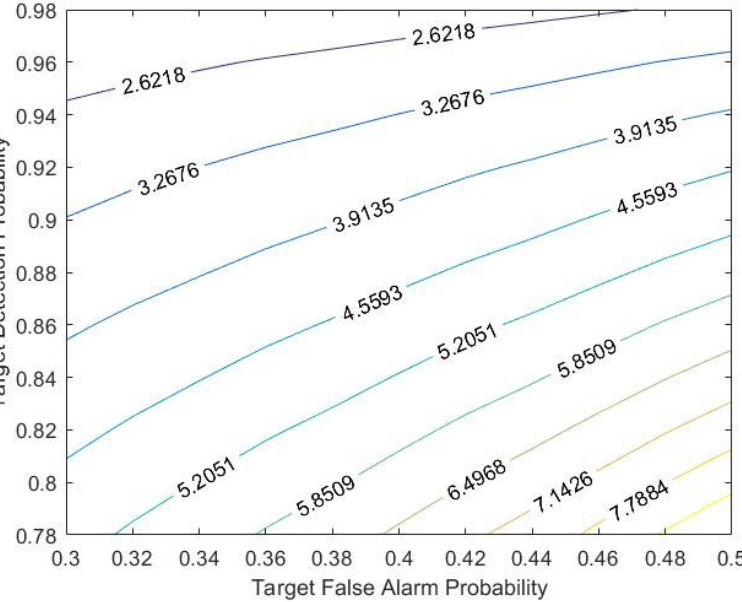
Figure 4. Contour lines of maximum idle/active ratio under sensing performances constraints.